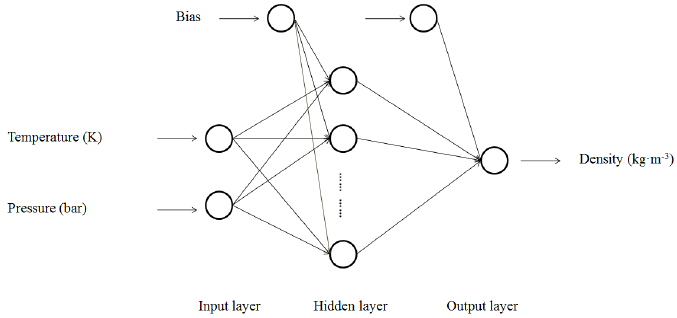
Figure 2. Schematic structure of an artificial neural network (ANN) for the prediction of compressed liquid densities of 1,1,1,2,3,3,3-heptafluoropropane